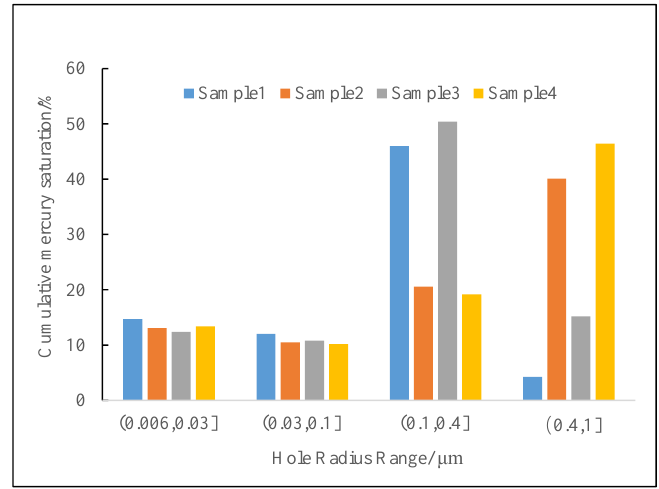
Figure 5. Pore distribution histogram when K < 1×10 −3 μm 2 .